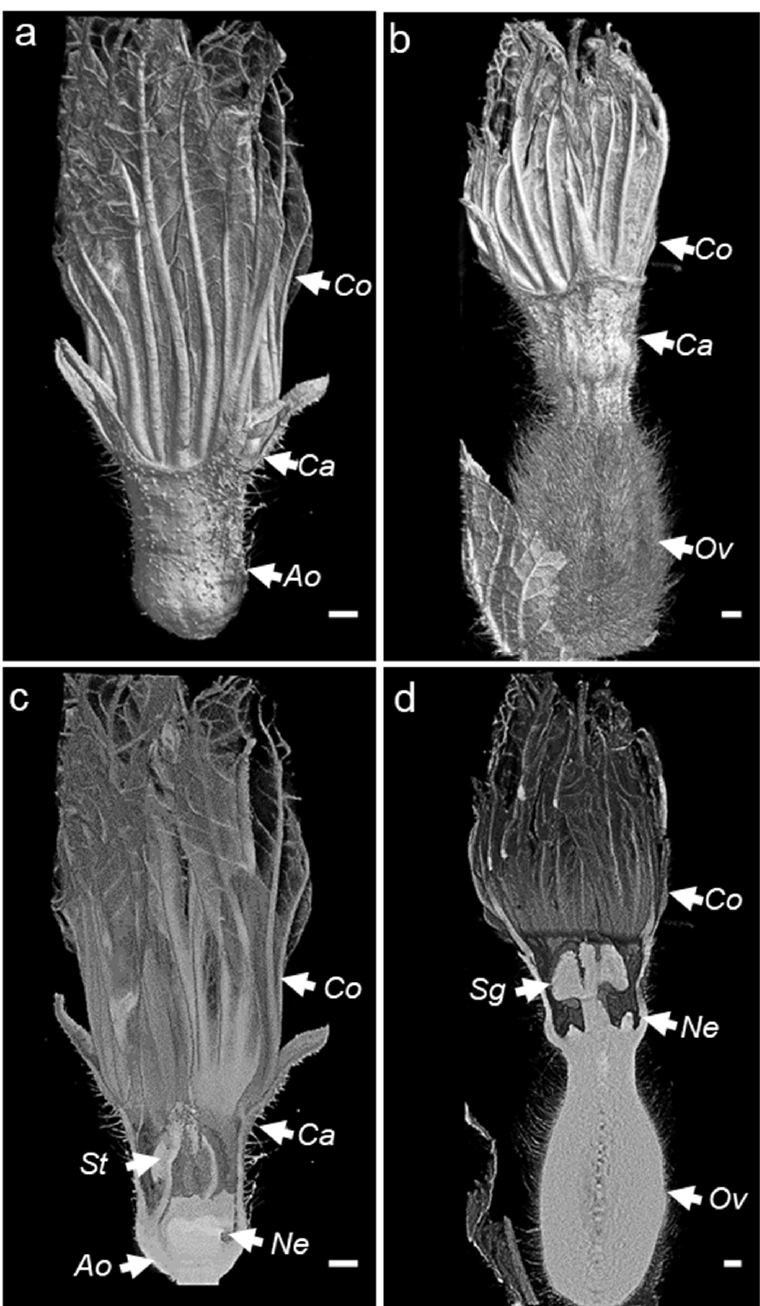
Figure 3. ( a – d ) External and cross‑sectional 3D overview of male ( a , c ) and female ( b , d ) melon flowers generated using Bruker CTvox software. Ov, ovary; St, stamen; Sg, stigma; Ne, nectary; Co, corolla; Ca, calix; Ao, aborted ovary; VOI, volume of interest. The scale bar represents 1 mm.